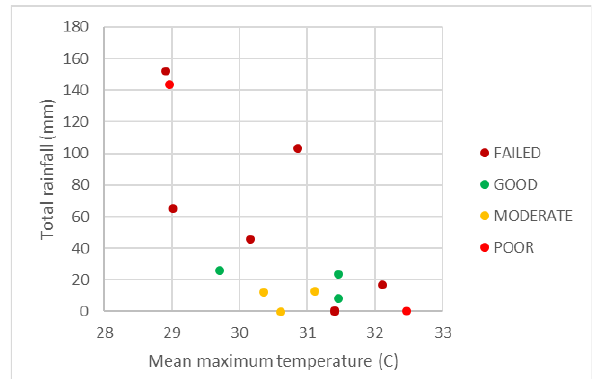
Figure 12. Annual summer weather conditions versus honey harvest quality